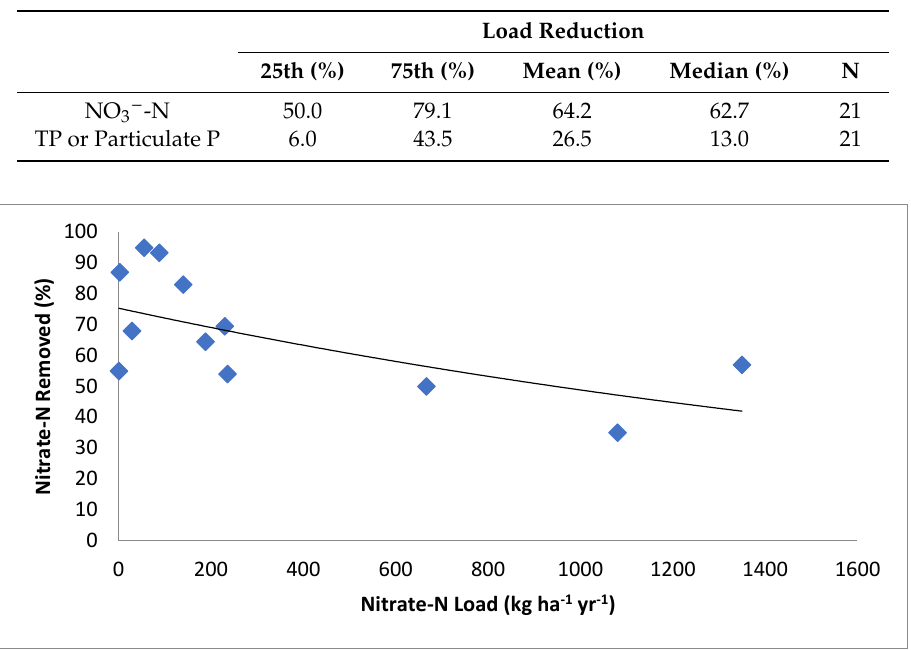
Figure 7. Increase in nitrate-N (NO 3 − -N) mass removed as the NO 3 − -N load into the floodplain increased (y = 0.2946x + 115.67, ρ = 0.70, p = 0.004). Table 2. Percent removal of nutrients in floodplains. Percent reductions in nitrate-N (NO 3 − -N) and total or particulate phosphorus (TP or particulate P) loads in floodplains from literature reviewed.